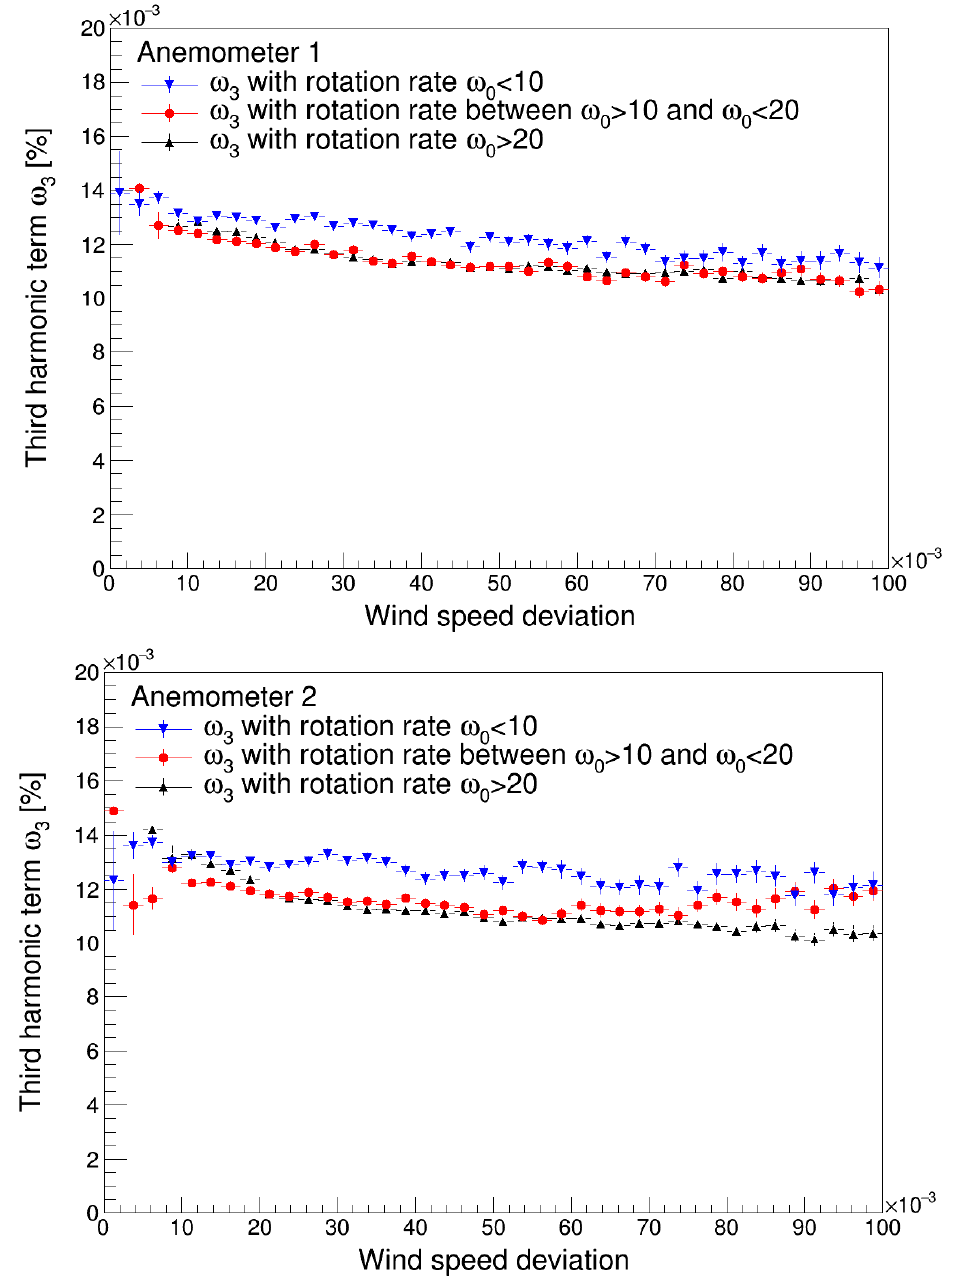
Figure 10. Third harmonic terms of Anemometer 1 ( top ) and Anemometer 2 ( bottom ) as a function of the non-dimensional wind speed deviation.